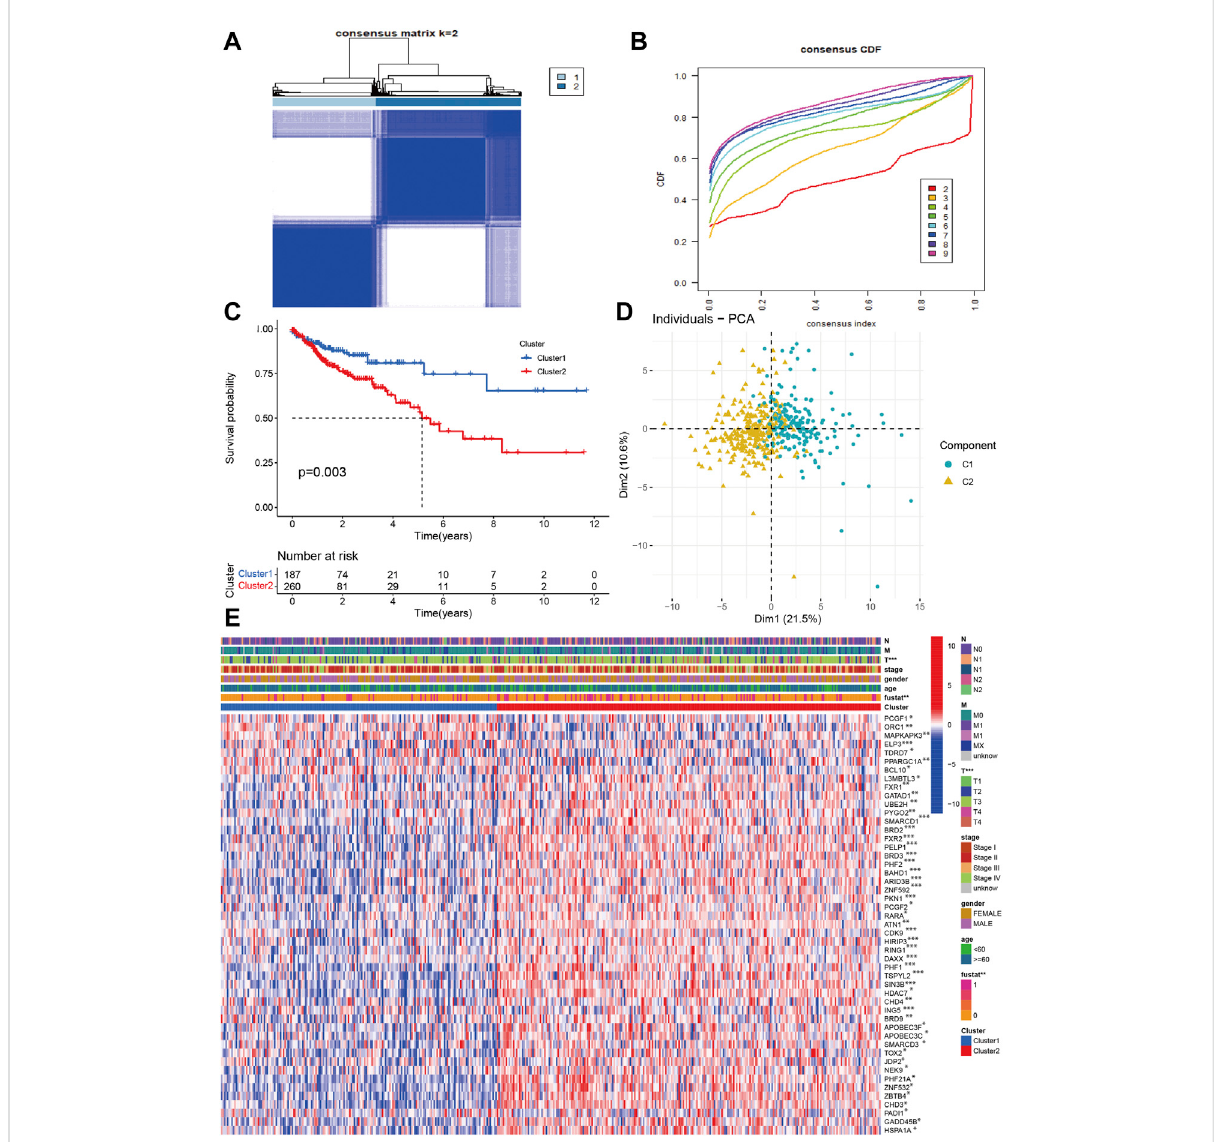
FIGURE 3 Identi fi cation of molecular subtypes based on chromatin regulators in OAD (A,B) The consensus matrix and CDF identi fi ed two subtypes in COAD. (C) The Kaplan-Meier survivalcurveoftwosubtypes. (D) PCAindicatedtwoobviouscomponents. (E) The correlations ofmolecular subtypes with clinical characteristics and gene expression pro fi